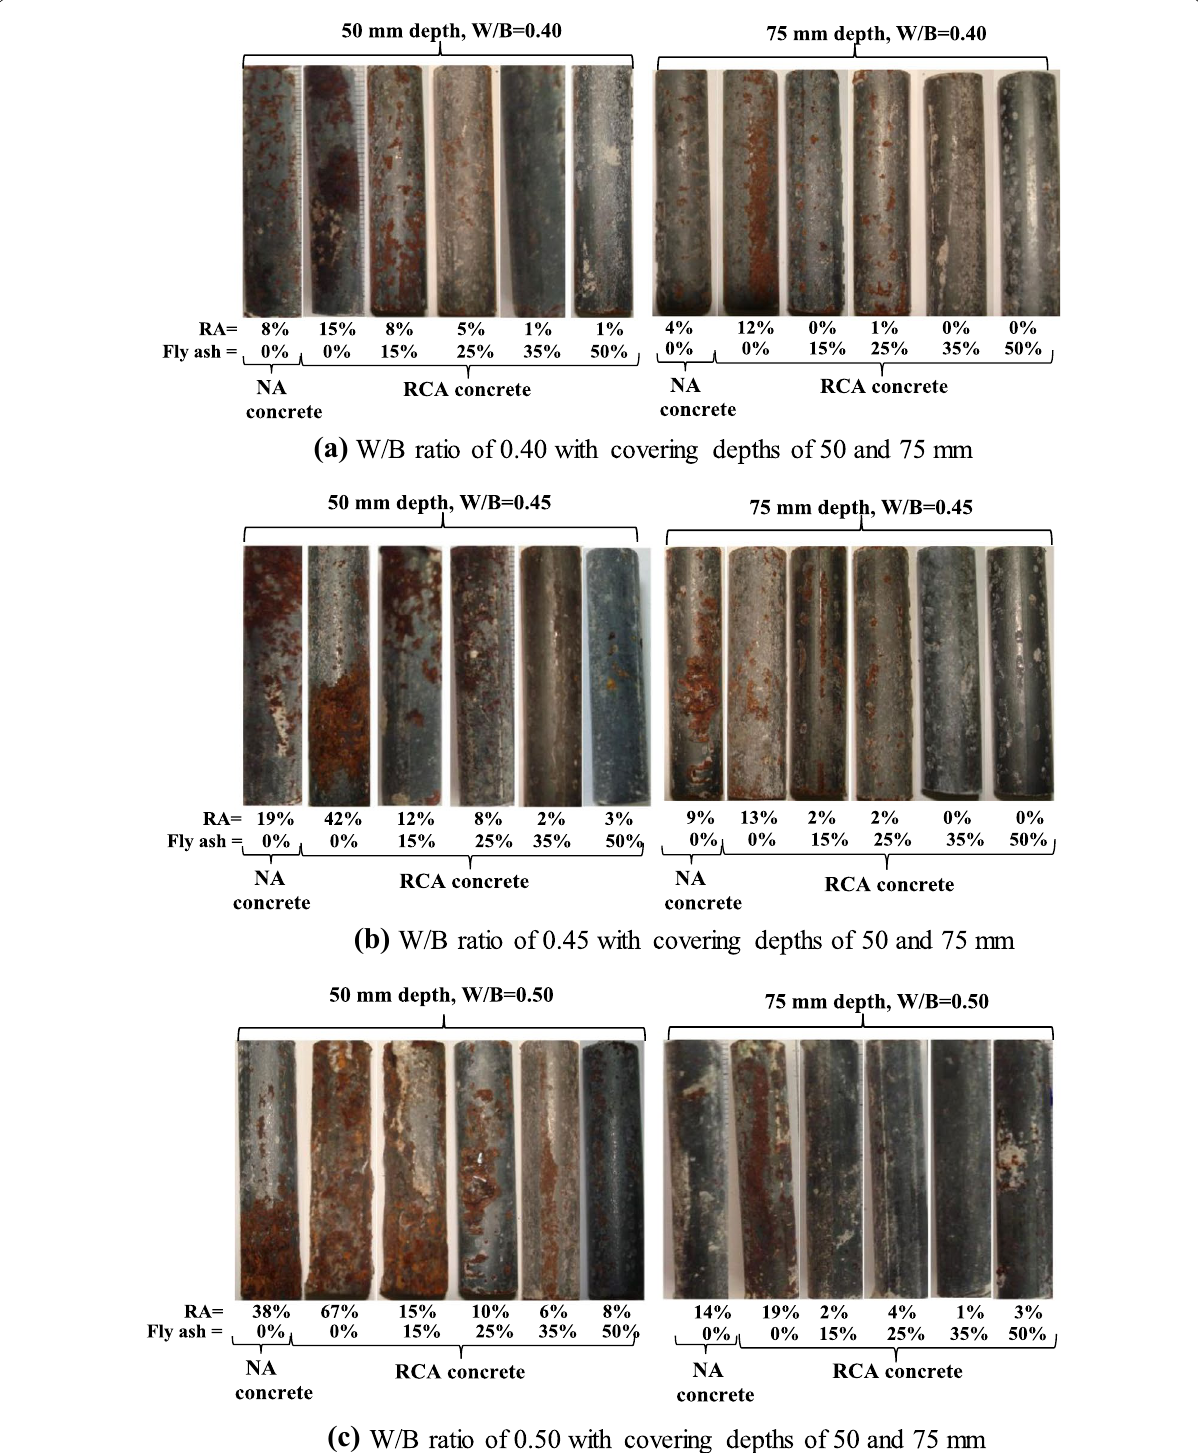
Fig. 8 Rusted area of embedded steel in NA and RCA concretes with a W/B of a 0.40, b 0.45 and c 0.50 after 7-year exposure in a marine